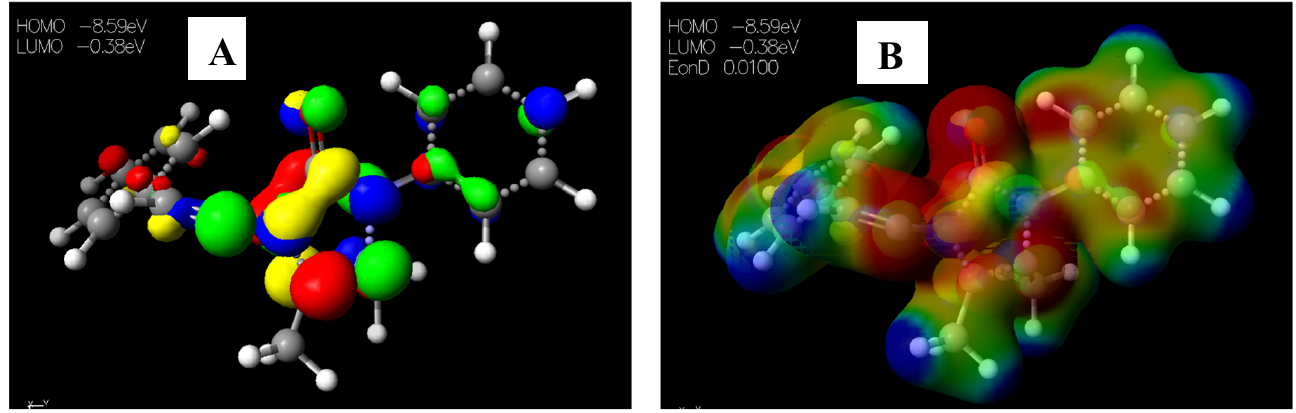
Figure 6. Images showing the ( A ) Highest occupied molecular orbital (HOMO) and Lowest unoc- cupied molecular orbital (LUMO) and ( B ) Molecular electrostatic potential (MESP) plots of 2.